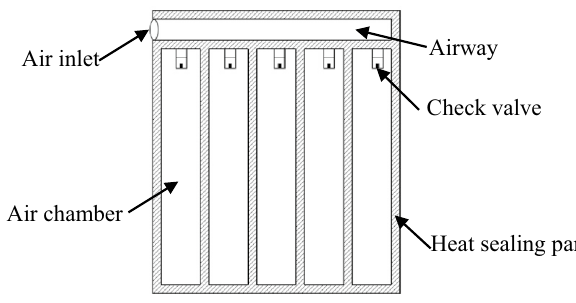
Fig. 1 Air column bag structure